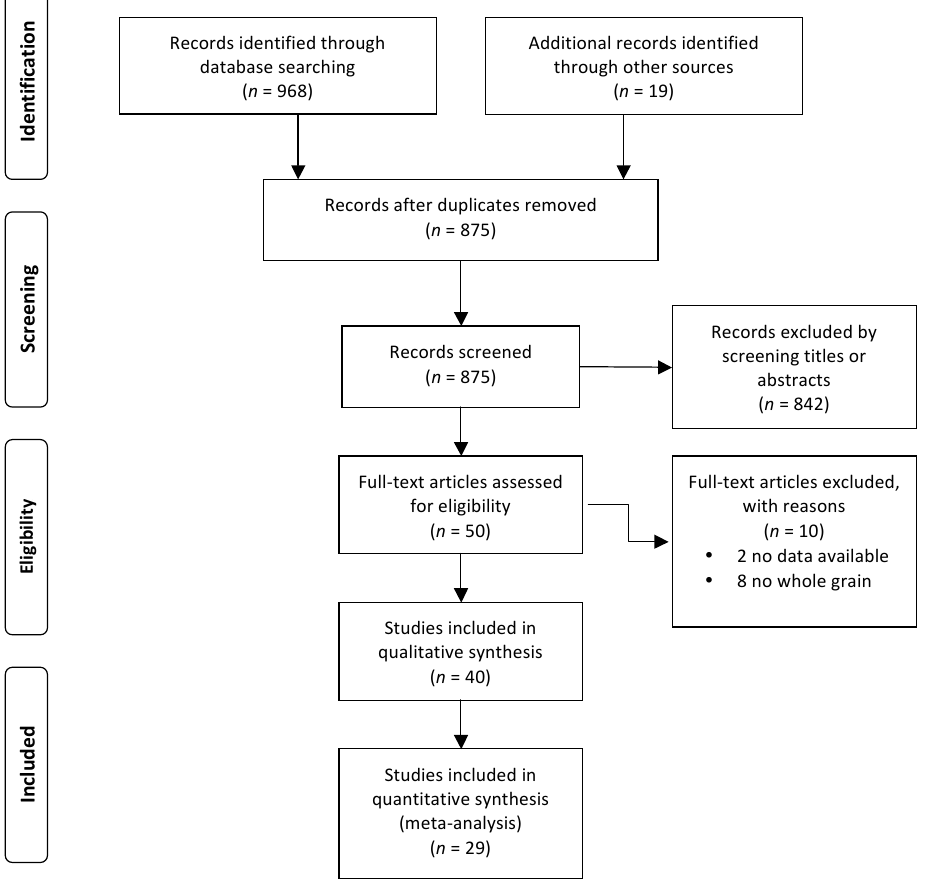
Figure 1. PRISMA flowchart indicating the results of the search strategy.